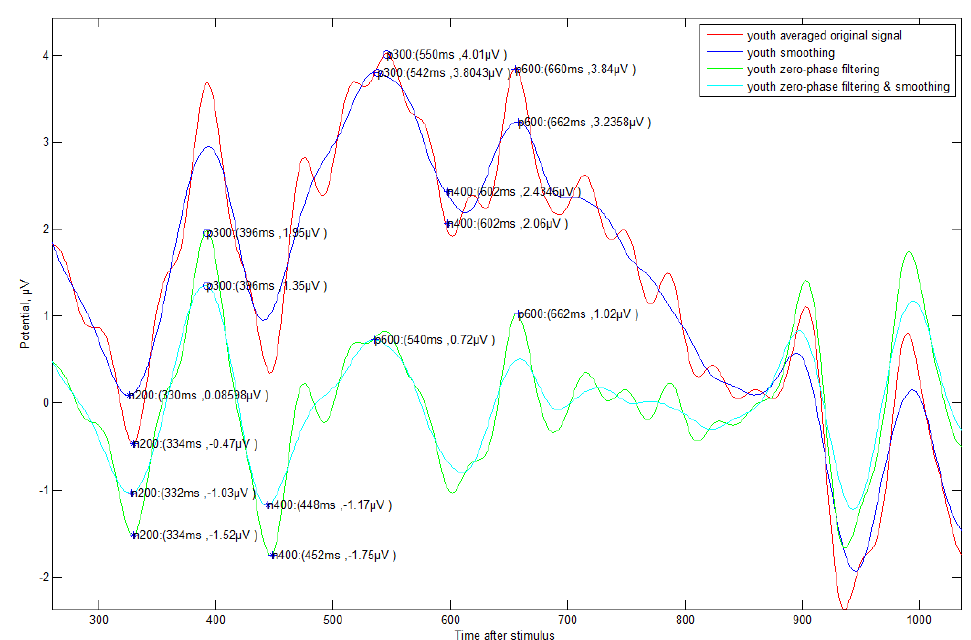
Figure 9. ERP Case Study 3—Young subject (#1)’s correct answer about triangle symbol: It can be seen that the viewpoint of each event component is faster than that of the elderly, and the fluctuation is small.